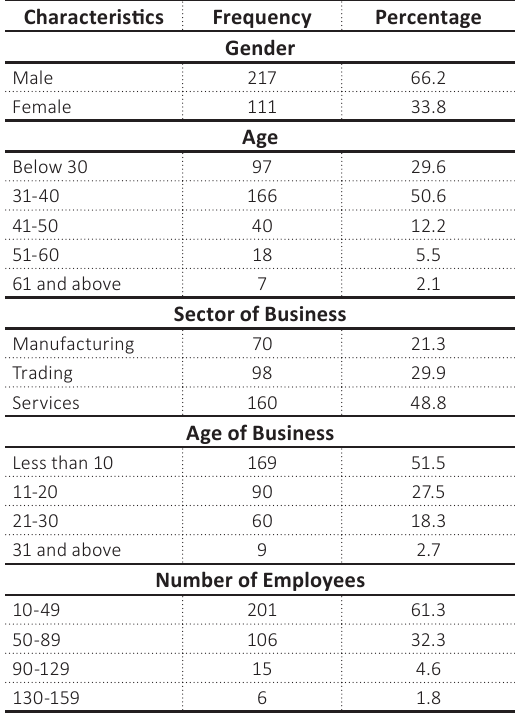
Table 2. Validity and reliability of measuring